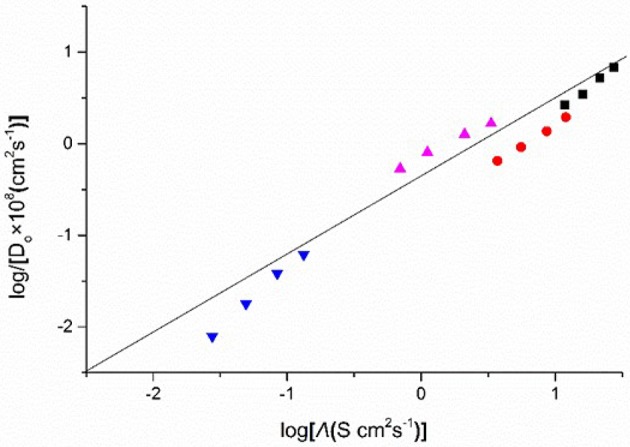
Logarithm of diffusion coefficients (Do) of Eu(III), against as a function of log(molar conductivity, Λ), measured in [C4mim][N(CN)2] (black), [C4m2im][N(CN)2] (red), N4442[N(CN)2] (blue), and N8444[N(CN)2] (violet).